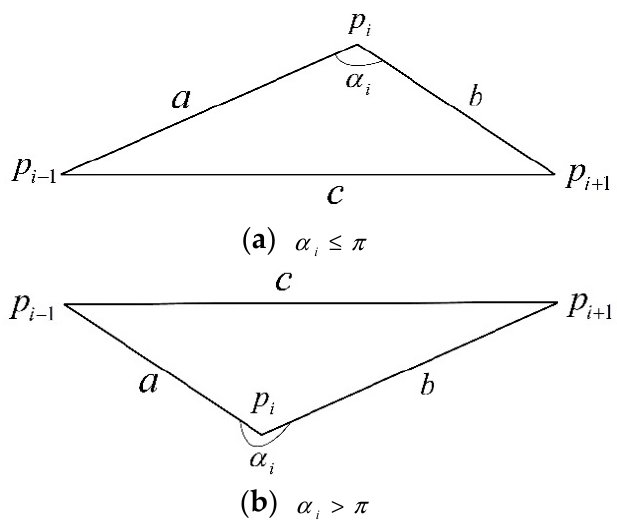
Figure 2. Schematic diagram of angles.